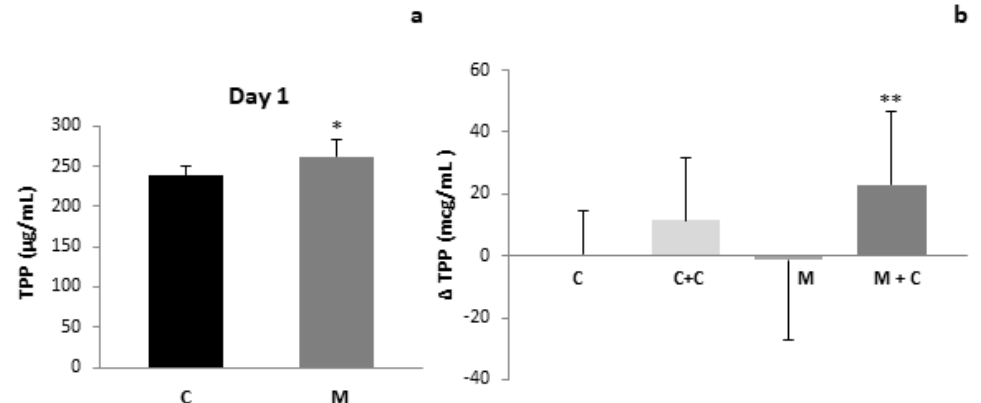
Figure 2. ( a ) Total polyphenol content of human milk of Control and Mastitis groups ( p < 0.05 vs C). ( b ) Variation of total polyphenol content of human milk along the study of Control, Control + Cranberries, Mastitis and Mastitis + Cranberries groups. Control (C), Control + Cranberries (C + C), Mastitis (M) and Mastitis + Cranberries (M + C). * p < 0.05 vs C, ** p < 0.05 vs C and M. The GSH concentration of milk was not significantly affected by mastitis (Figure 3a).